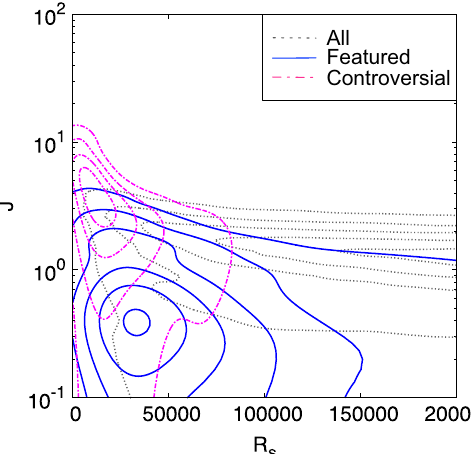
Figure 4. Distribution of the “featured”, and “controversial” articles in the R s (strength rank)- J (complexity- strength rank ratio) plane. The “featured” articles are distributed in the small J < 1 region and well separated from the “controversial” articles which are peaking at J > 1